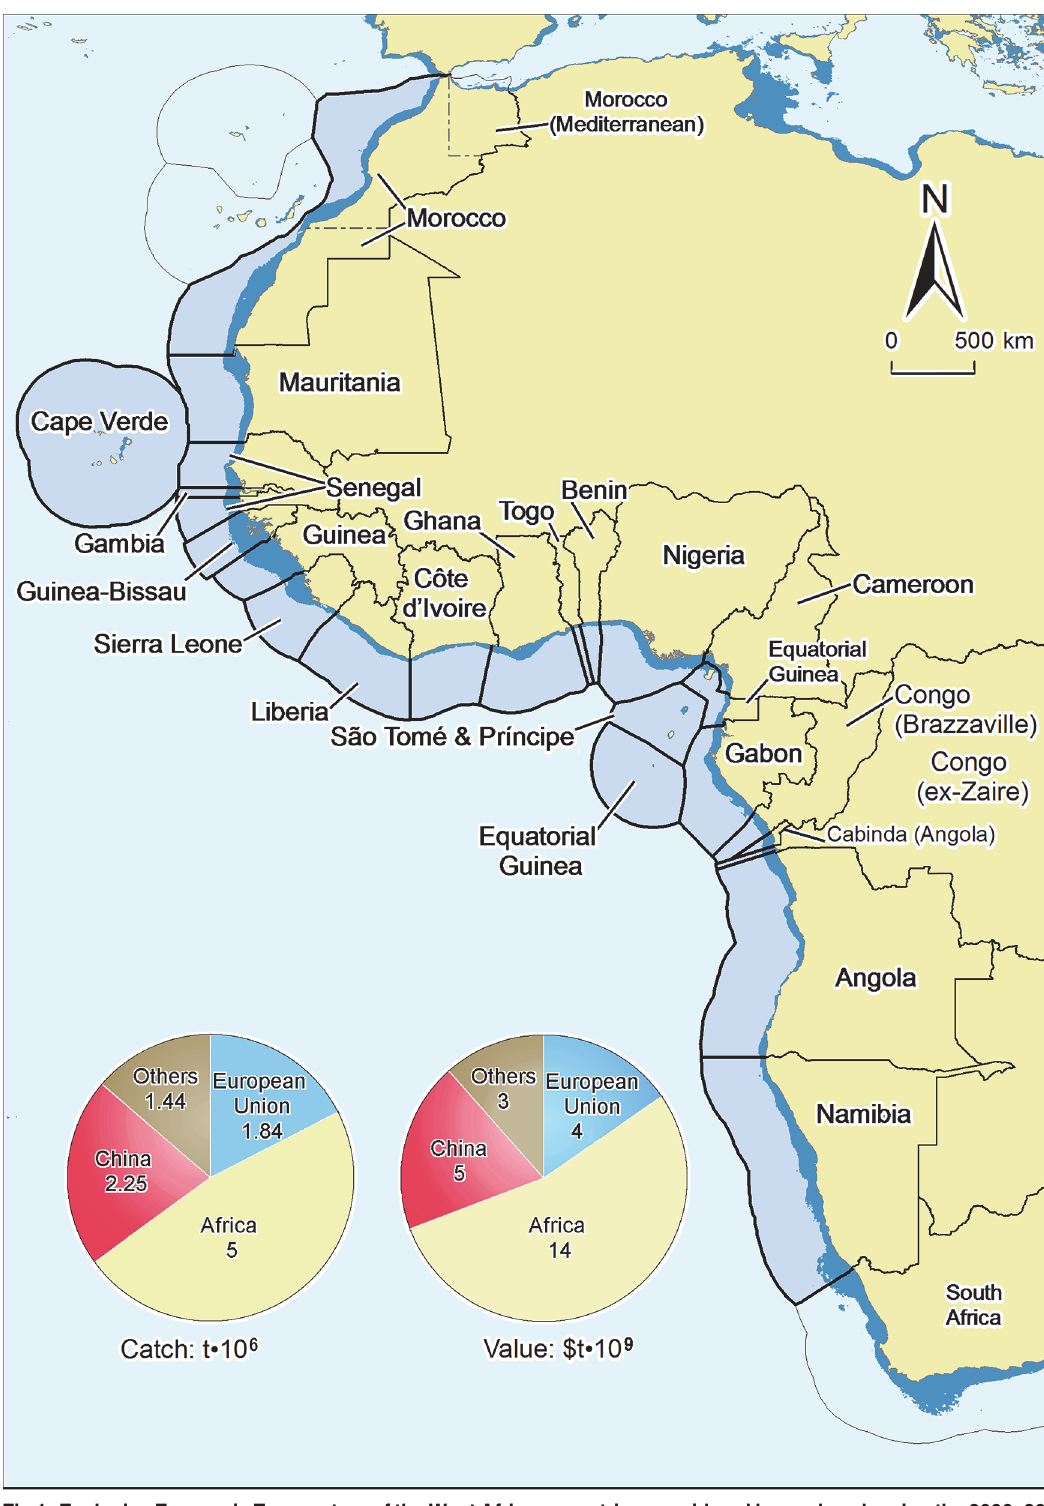
Fig 1. Exclusive Economic Zone waters of the West African countries considered here, also showing the 2000 – 2010 average annual catch and landed value of their marine fisheries, incl. distant-water fleets.